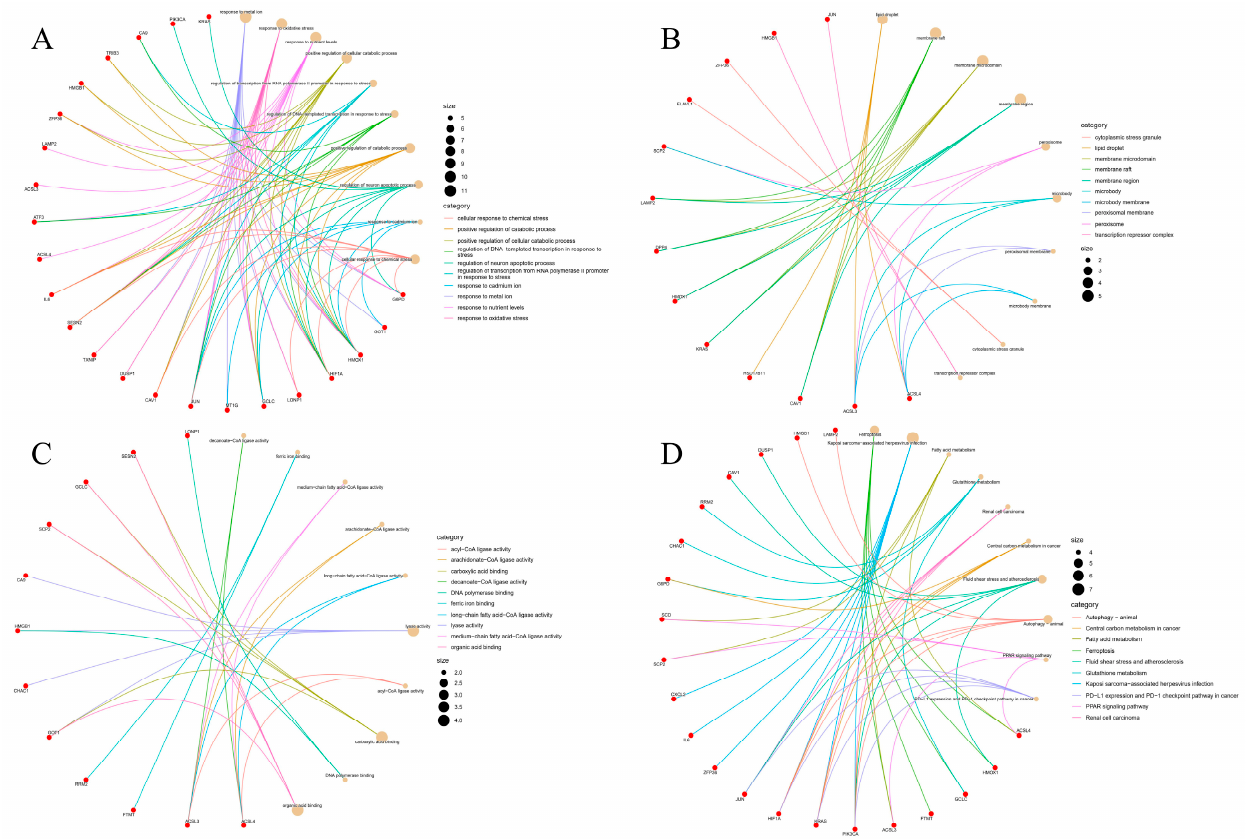
Figure 2. Analysis of differentially expressed mRNA (DEGs) enriched by GO and KEGG pathways. ( A ) Top ten MF analysis. ( B ) Top ten CC analysis. ( C ) Top ten MF analysis. ( D ) The bubble chart shows the KEGG pathway in the top 10 DEGs.